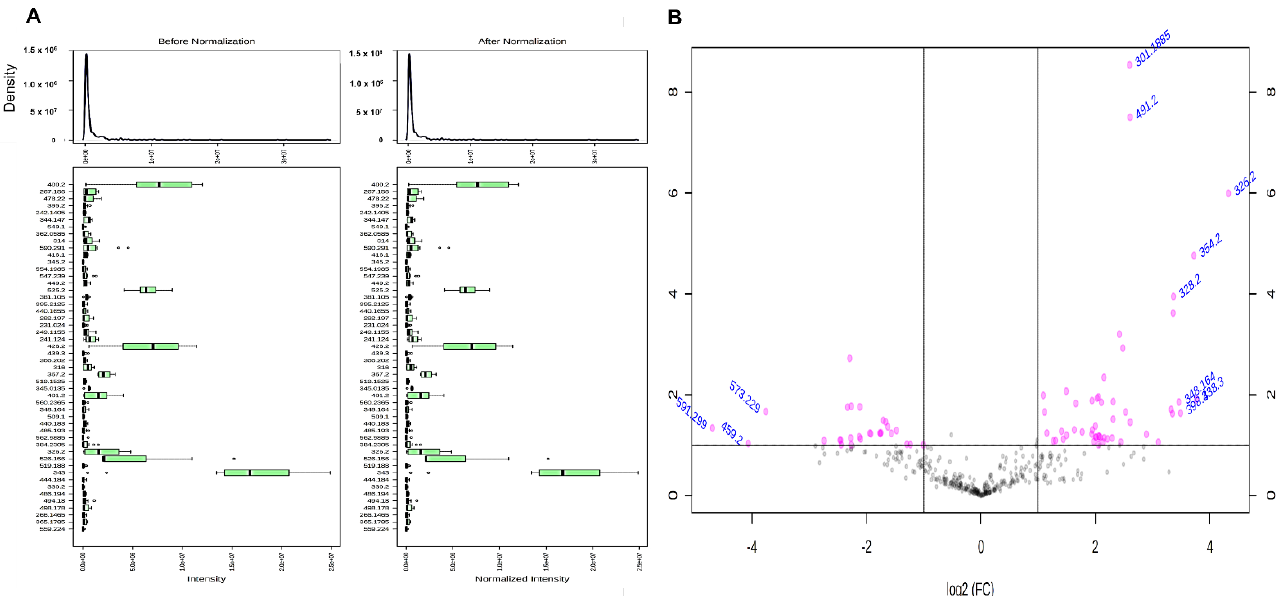
Figure 3. ( A ). A representative figure showing the identified proteins before and after normalization of proteins from three groups, ( B ). Volcano plot of the identified proteins and their differential expressions in log2 scale.